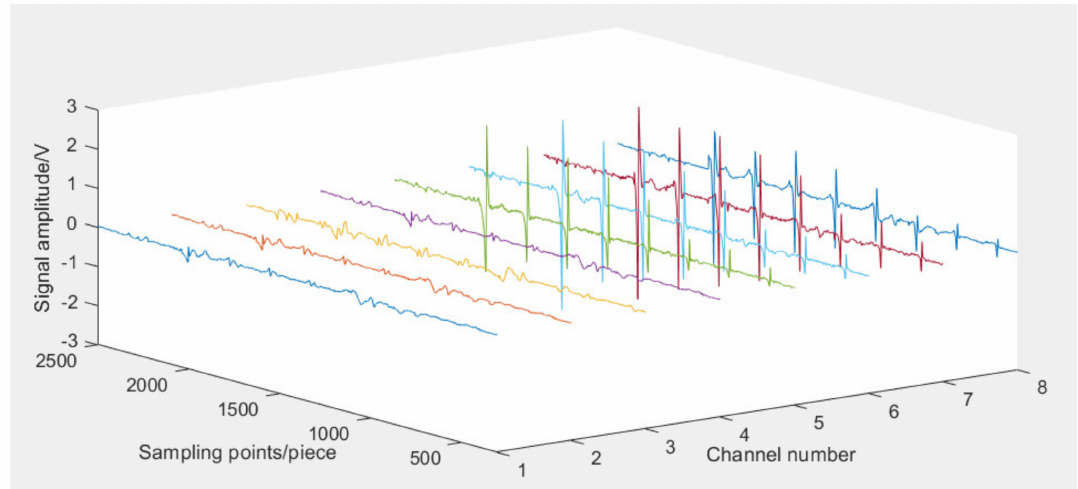
Figure 16. Multichannel filtered